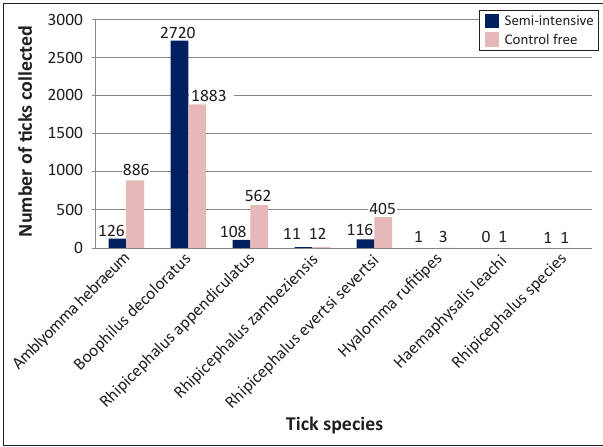
FIGURE 2: Tick numbers per species collected in the controlled (semi-intensive) and uncontrolled areas of the study